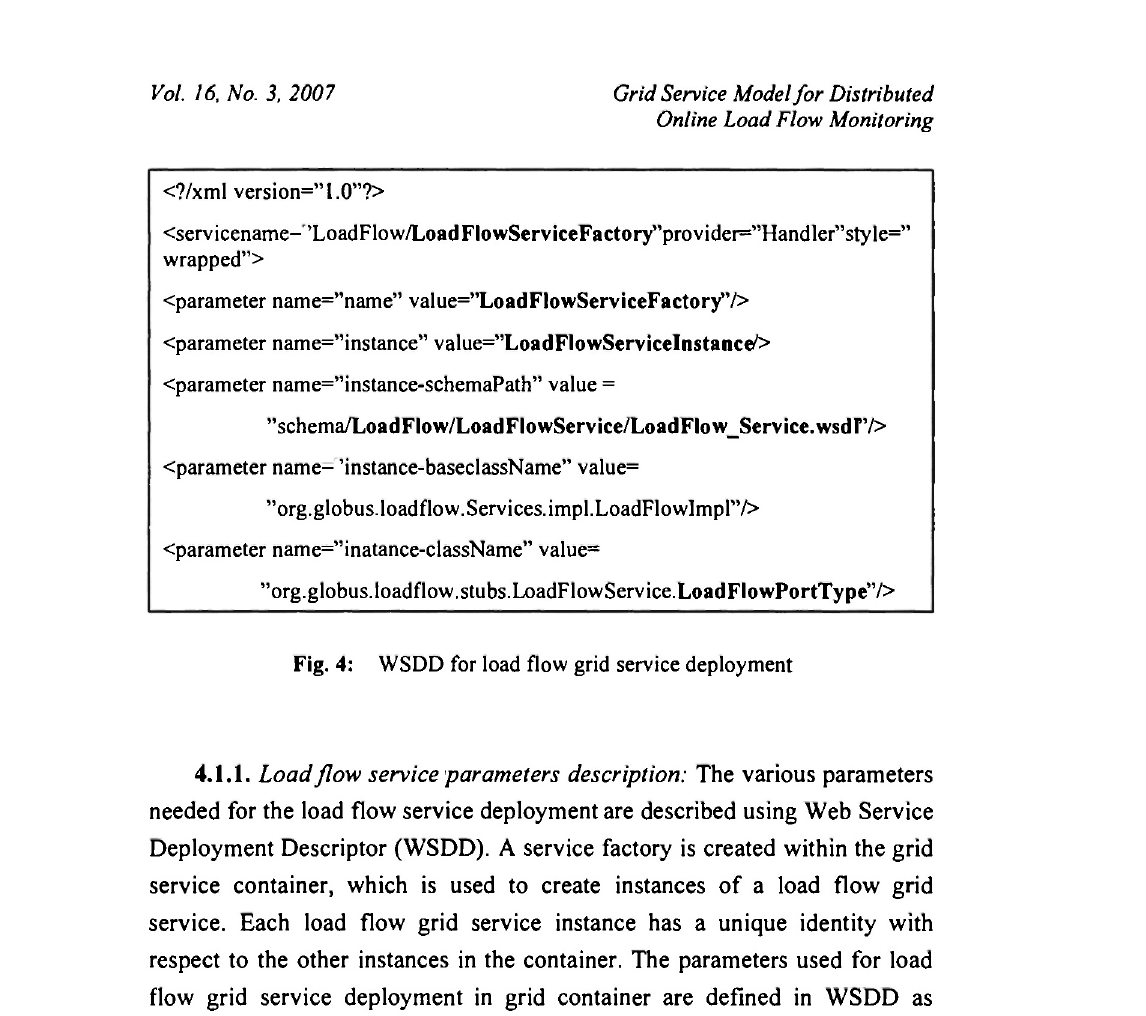
4.1.1. Load flow service parameters description: The various